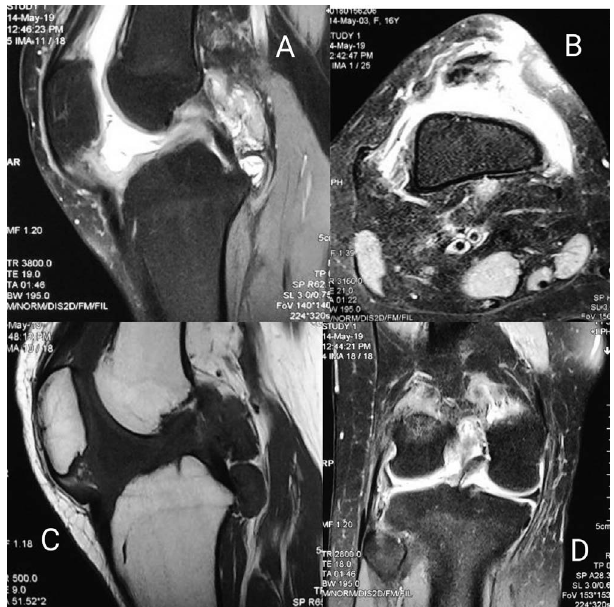
Figure 5. Figure showing MRI sections of a patient with pigmented villo-nodular synovitis of knee (A – sagittal STIR, B – axial STIR, C – sagittal T1, D – coronal STIR images showing nodular synovial thickening with foci of blooming within patellar tendon, Hoffa ’ s pad of fat, quadriceps tendon, and popliteal